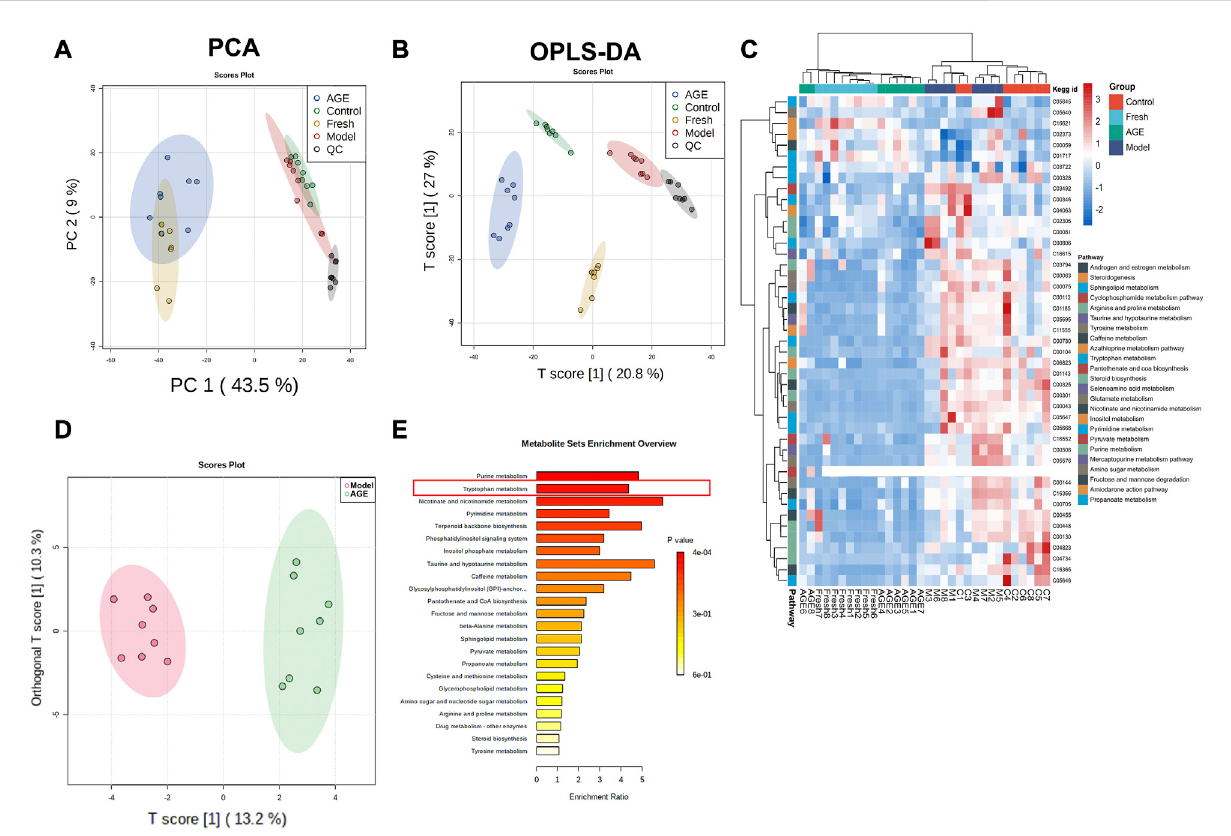
Comparison of serum metabonomic change between fresh GE and AGE in anxiety mice ( n = 8). (A) The score plots of principal component analysis (PCA) scores for serum samples, (B) OPLS-DA analysis for serum samples, (C) the heatmap comparison of metabolites in serum samples, (D) OPLS-DA score plots of Model and AGE group metabolites, (E) metabolic pathway enrich map in serum